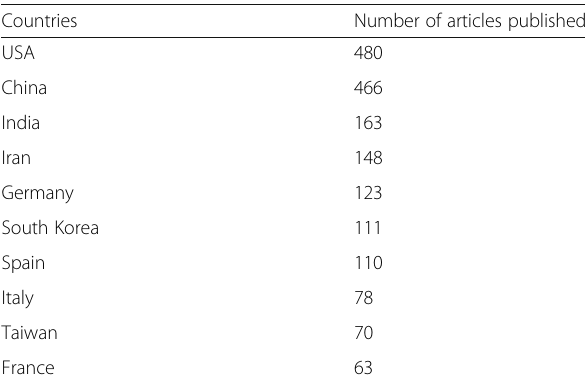
Table 2 Top 10 countries with their number of published